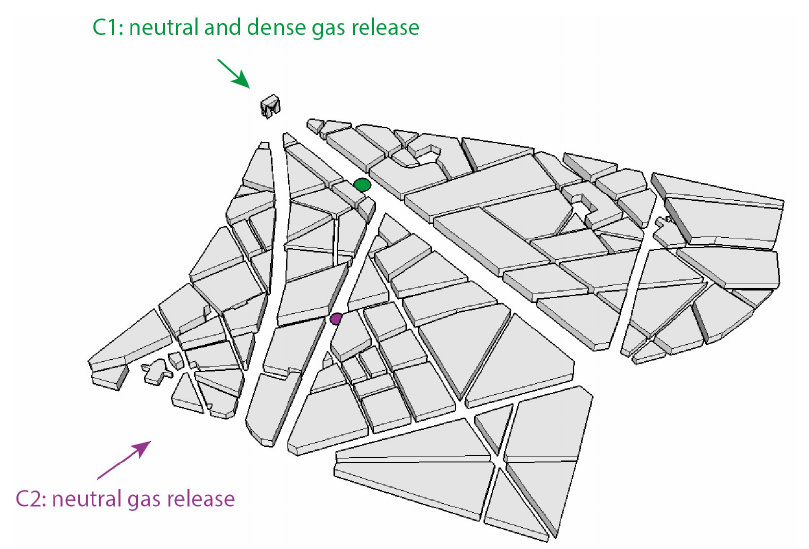
Figure 11. Configuration of the urban area dispersion case. Simulations were performed at reduced scale (1:350, H moy = 0.078 m) as in the refer- ence experiment [39], with a domain of 8.75 (C1) or 9.5 (C2) × 3.5 × 1.5 m 3 , with the model located 1.15 m from the inlet of the domain. Table 6 gives the different boundary